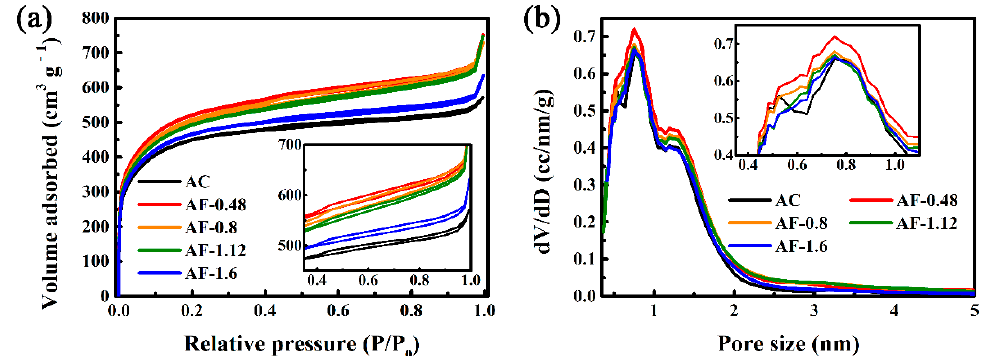
Figure 3. Ar adsorption/desorption isotherms ( a ) and corresponding pore size distributions ( b ) of AC and Fe@C composites.